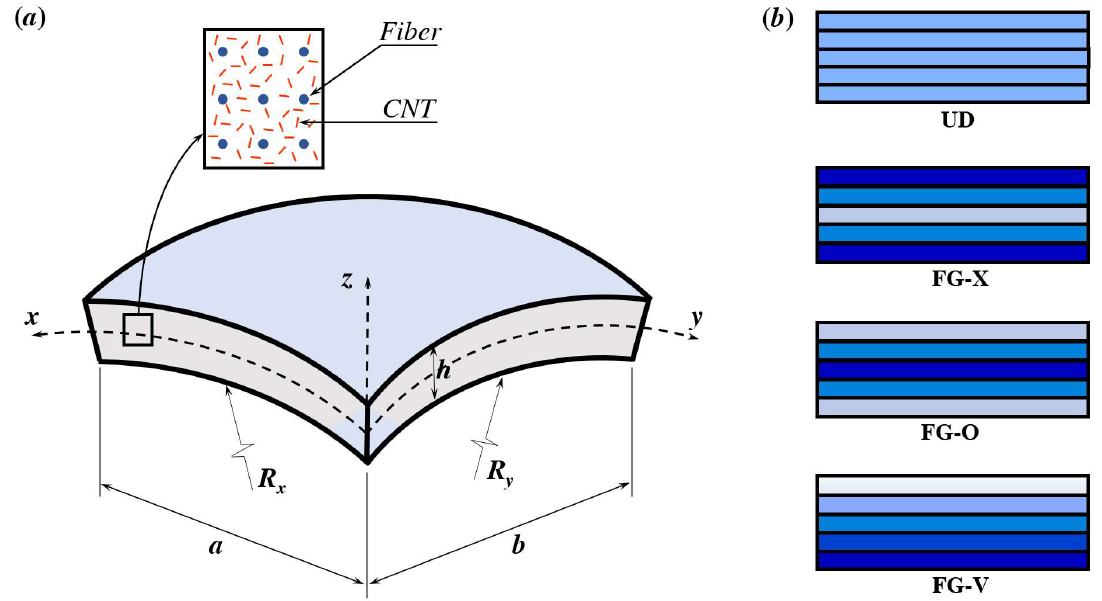
Figure 1. The material properties, geometry, and coordinate system of the shell, ( a ) Geometry and coordinates, ( b ) Gradation types of material.